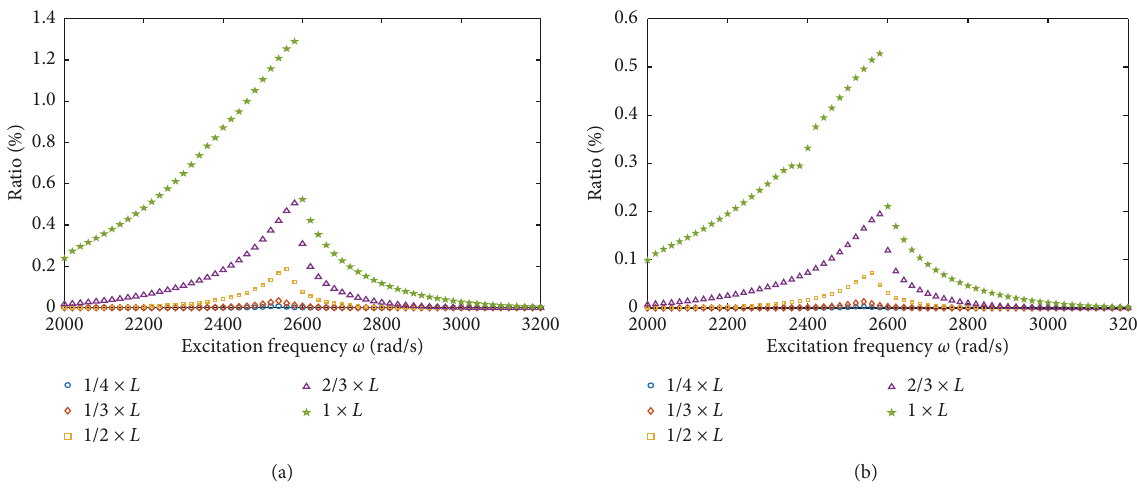
Figure 18: The energy ratio at different shroud positions. (a) The ratio of energy storage by the contact force. (b) The ratio of energy consumption by the friction